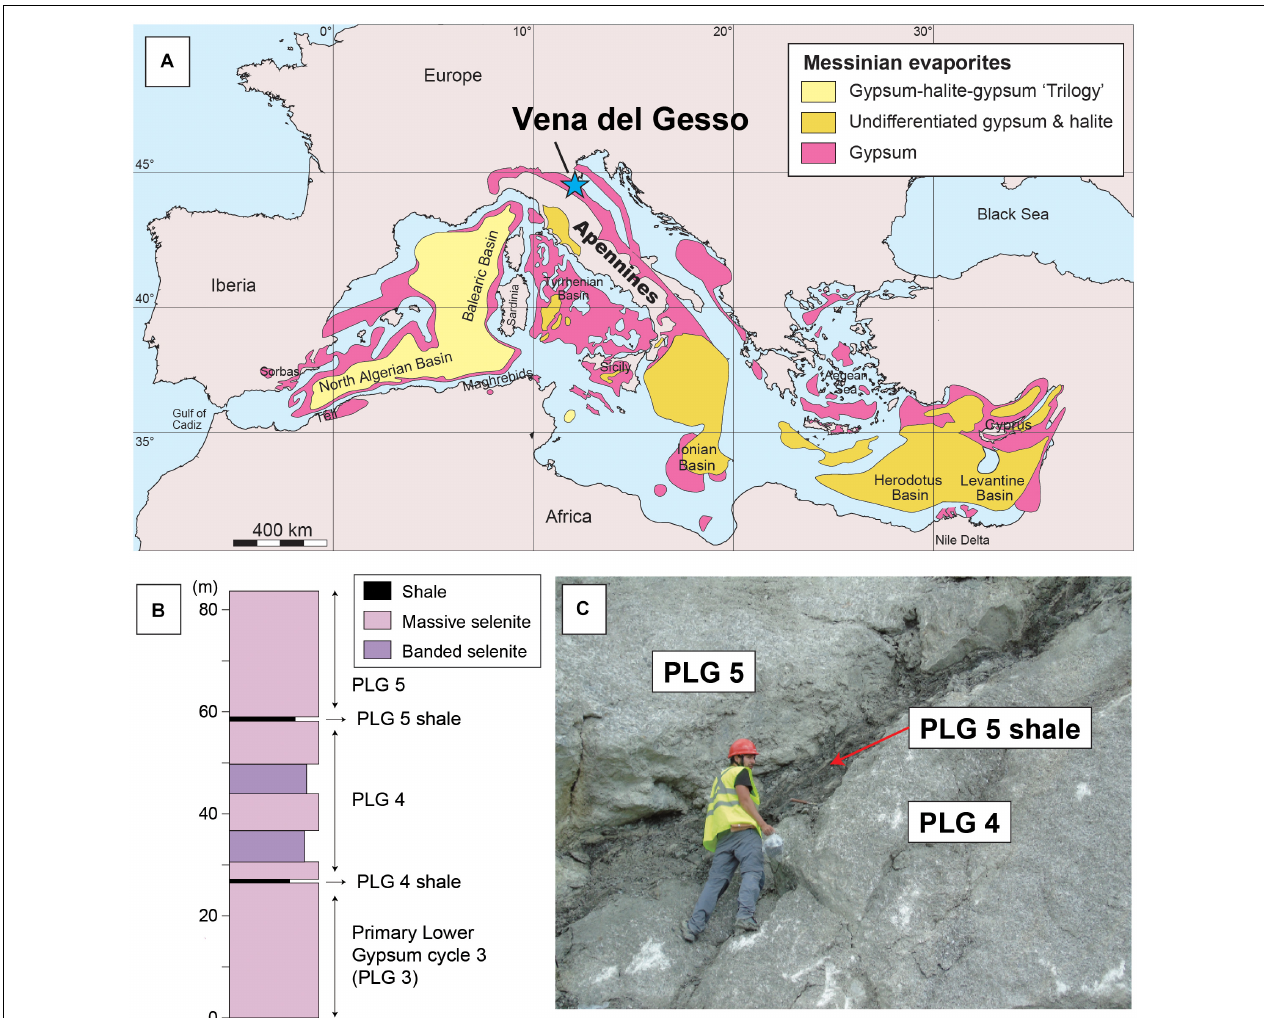
FIGURE 1 | (A) Map of the Mediterranean Sea showing the distributions of Messinian evaporites (after Ryan, 2009; Manzi et al., 2012). Samples were collected from the Monte Tondo quarry of the Vena del Gesso. (B) Stratigraphic column of cycles 3, 4, and 5 of the Primary Lower Gypsum (PLG) deposited during the Messinian salinity crisis. The shales analyzed in this study were deposited during the humid climate phases of the insolation maxima. Modified after Lugli et al. (2010). (C) The boundary between the 4th and 5th cycles at the Monte Tondo quarry of the Vena del Gesso. Samples were collected from the middle part of the shale beds. Written informed consent was obtained from the individual for the publication of this